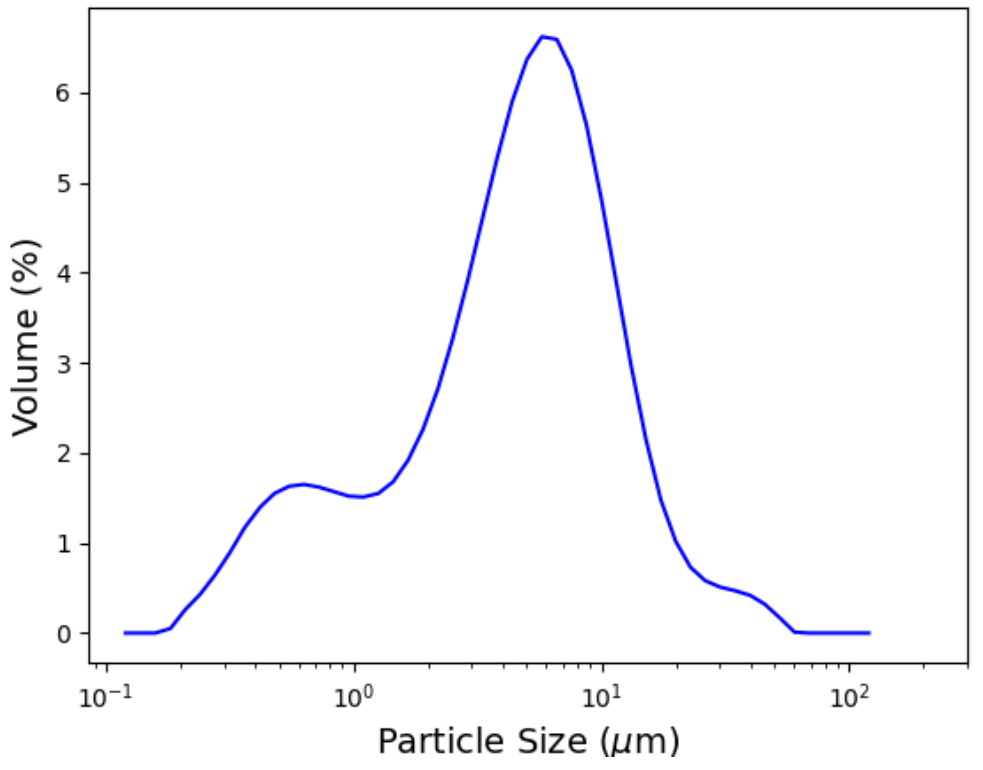
Figure 1. Particle size distribution of the as-received raw material. d(0.1) = 0.7 µm, d(0.5) = 5.1 µm, and d(0.9) = 13.6 µm.